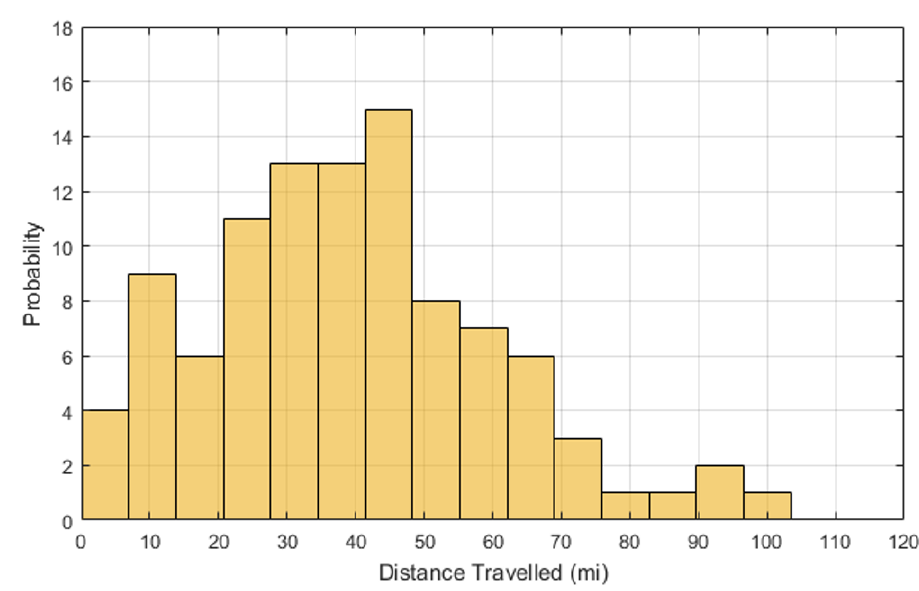
Figure 5. EVs’ daily distance